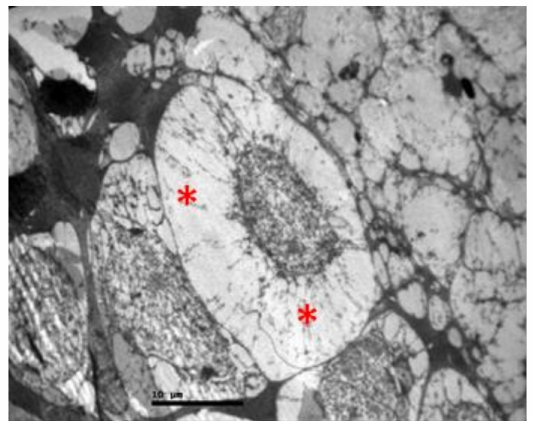
Figure 11. Group V. Ganglion cell with vacuolization of the cytoplasm and dilatation of the rough endoplasmic reticulum in the ganglion cell layer. (*).